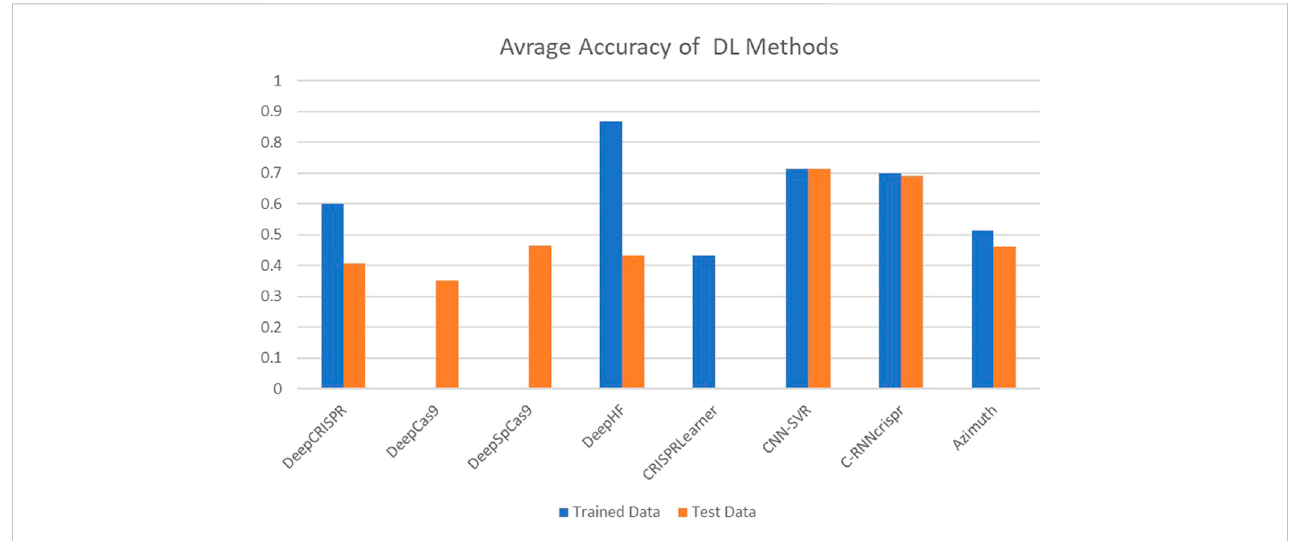
FIGURE 6 Average accuracy of off-target prediction in DL-based